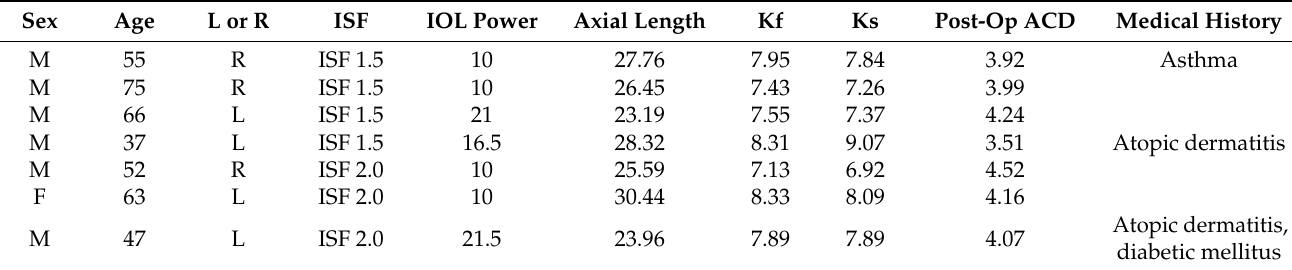
Table 2. Background of the iris capture patients.